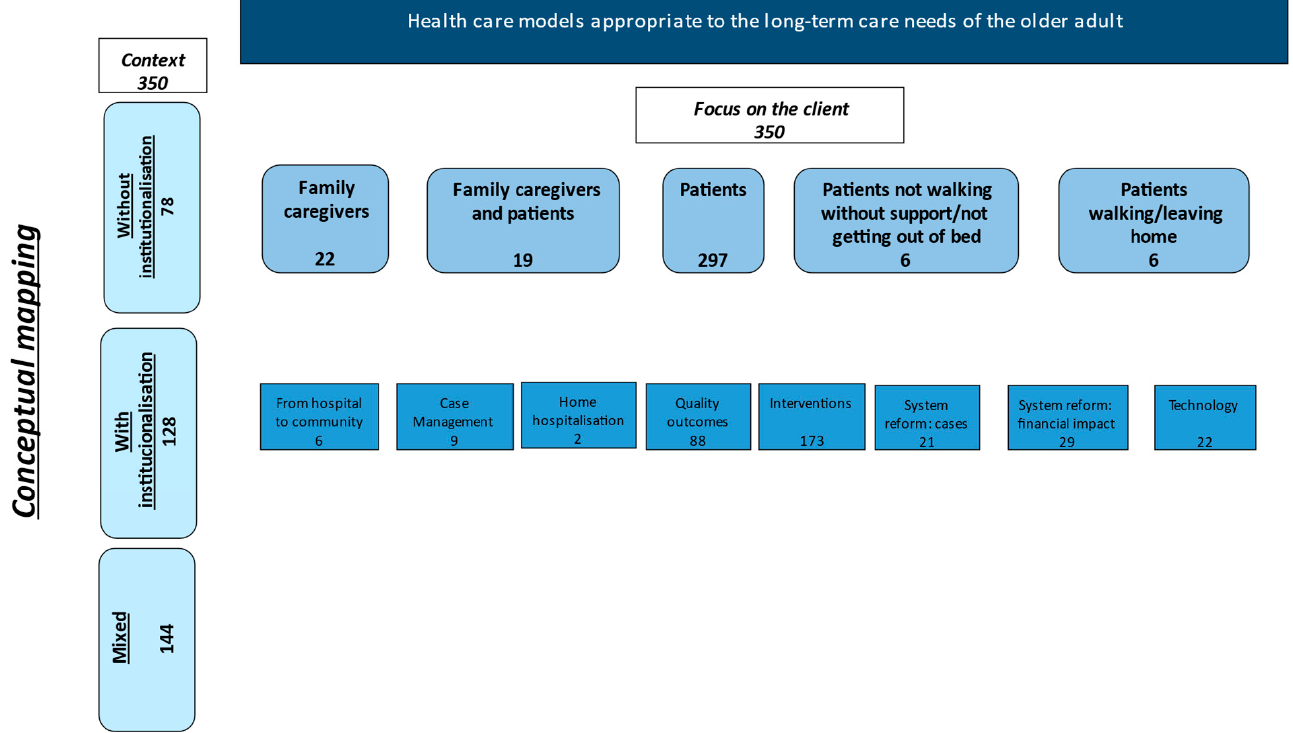
Figure 2. Conceptual mapping scheme.